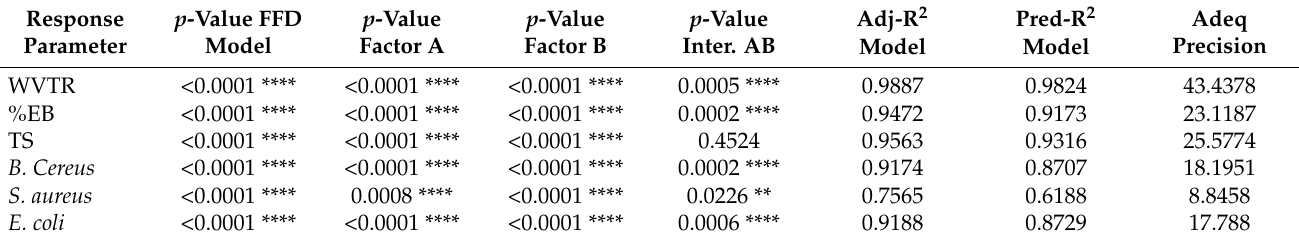
Table 2. Results of ANOVA (full factorial model) and fit statistics.